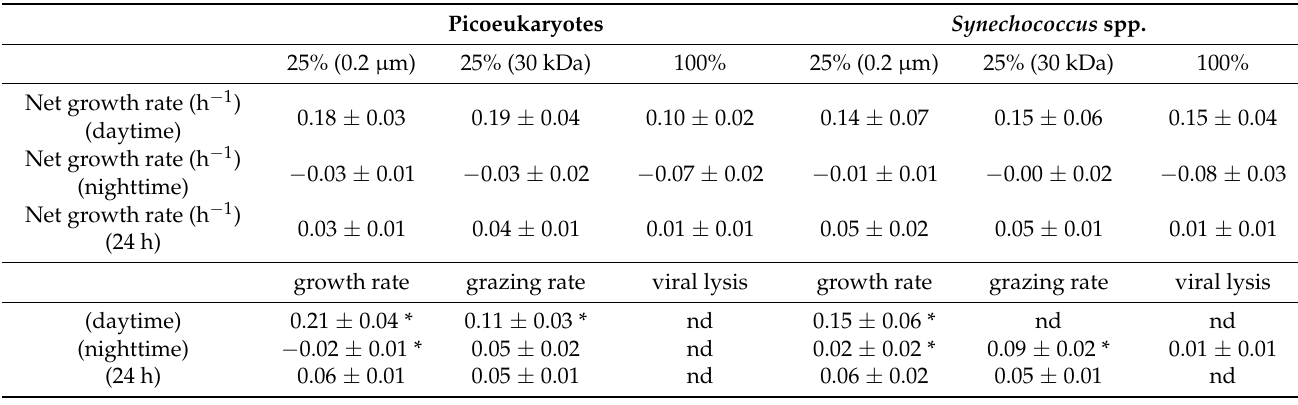
Table 1. Net growth rates of picoeukaryotes and Synechococcus spp. in each treatment at daytime, nighttime, and 24 h incubation. Growth, grazing, and viral lysis rates of picoeukaryotes and Synechococcus spp. were calculated based on net growth rates in each treatment at daytime, nighttime, and 24 h incubation. * Significance of the difference between the value of daytime or nighttime and 24 h incubation. ± represents the SD estimated from triplicate measurements. nd: not detected. Picoeukaryotes Synechococcus